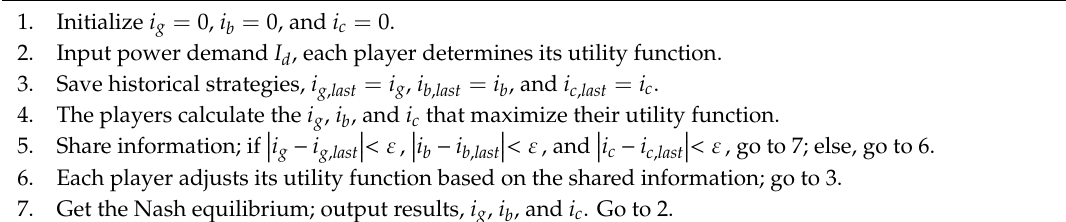
Algorithm 1. Nash equilibrium solution